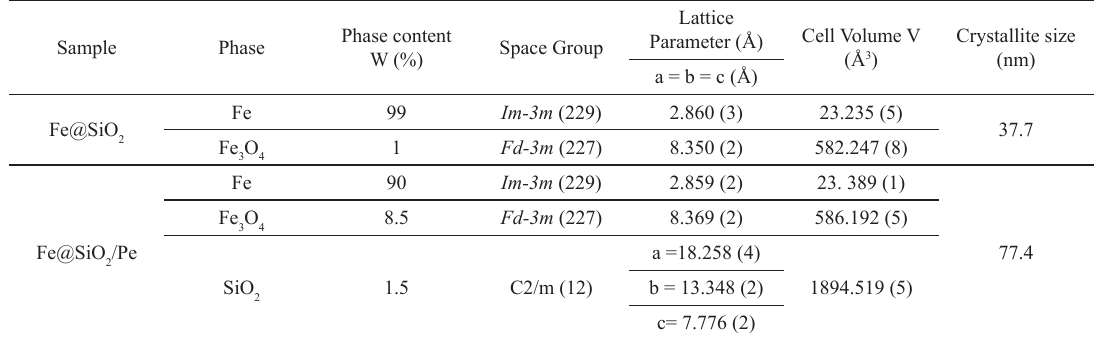
Table 1. Structural parameters obtained by Rietveld refinement of nanoparticles.